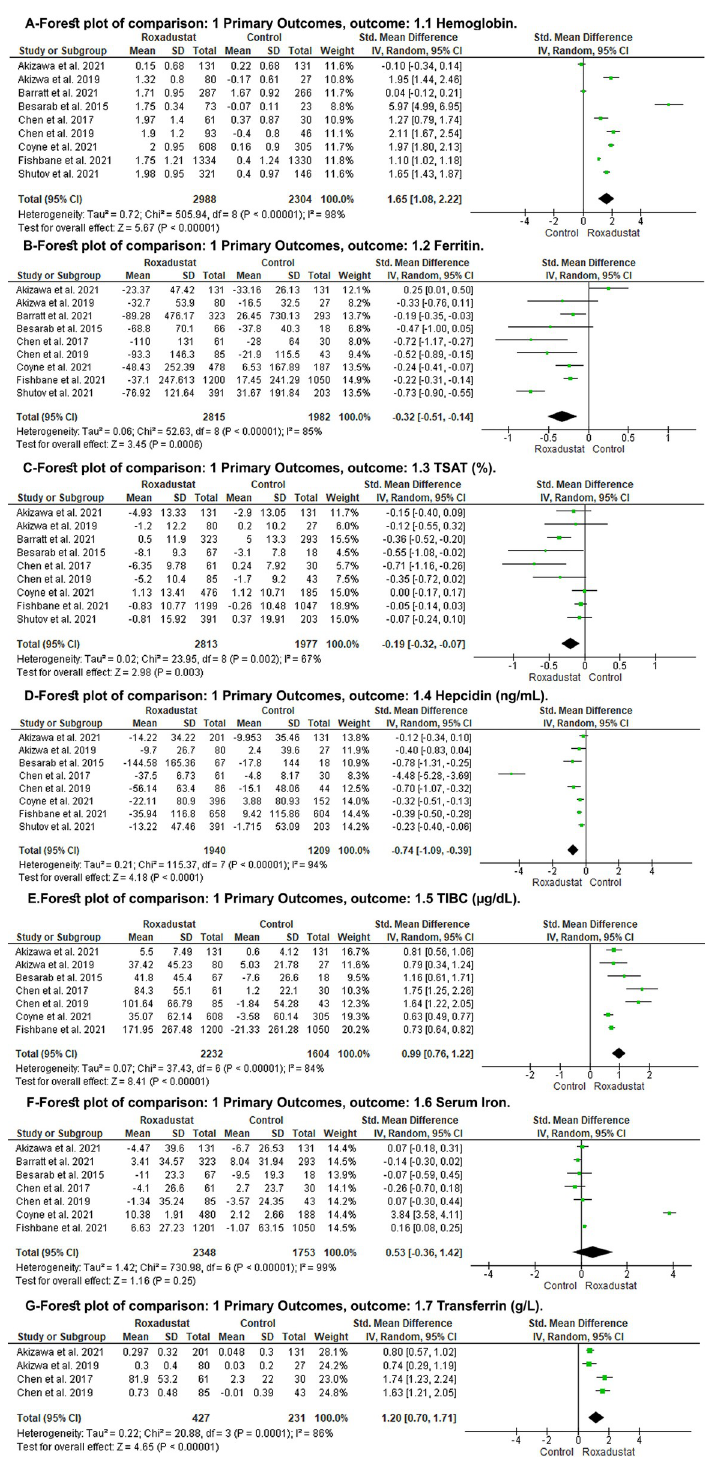
Fig 3. Forest plot of the primary outcomes. A: hemoglobin level; B: ferritin; C: TSAT; D: hepcidin; E: TIBS; F: serum iron; G: transferrin; CI: confidence interval; M-H: Mantel-Haenszel; df: degrees of freedom; I 2 , I-squared.